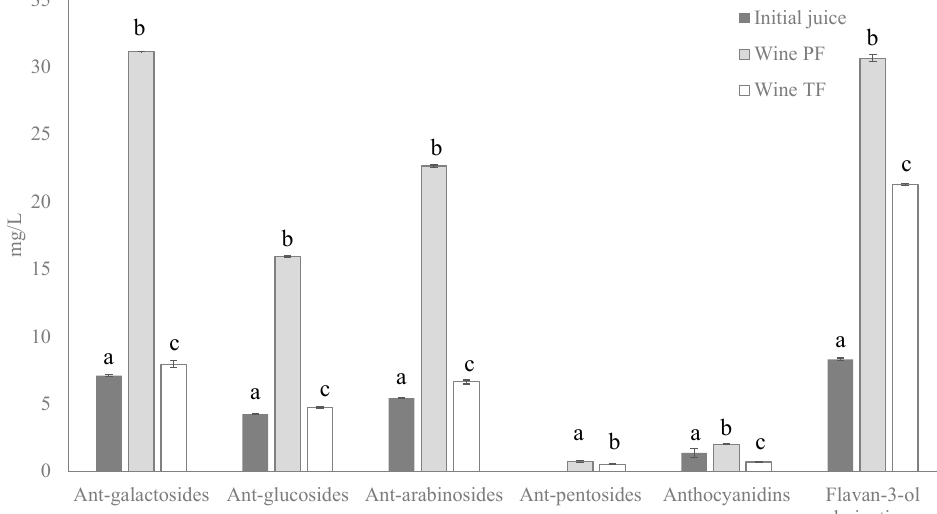
Figure 4. Concentration (mg/L) of 3-monogalactosides, 3-monoglucosides, 3-arabinosides and 3-pentosides derivatives of anthocyanins and anthocyanidins and flavan-3-ol derivatives in initial juice and wines from Windsor blueberry (means and standard deviations). Values with different superscript letters are significantly different, p = 0.01.